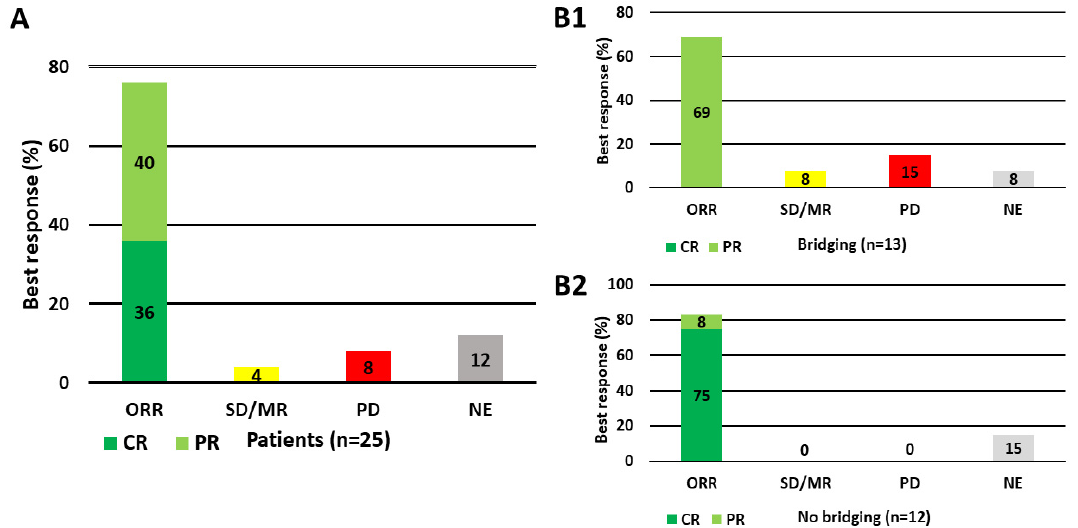
Figure 4. Best response (%) in patients receiving leukapheresis for axicabtagen ciloleucel. A total of 25 patients, all receiving leukapheresis for axicabtagene ciloleucel, were investigated for response (CR = complete response, PR = partial response, SD / MR = stable disease / mixed response, PD = progressive disease, NE = not evaluable). In 12% of patients, no remission data was available, either due to death of progressive disease prior to staging or not yet processed staging CT scans. ( A ) = all patients, ( B ) = patients requiring bridging ( B1 , upper panel) vs. patients requiring no bridging ( B2 , lower panel).